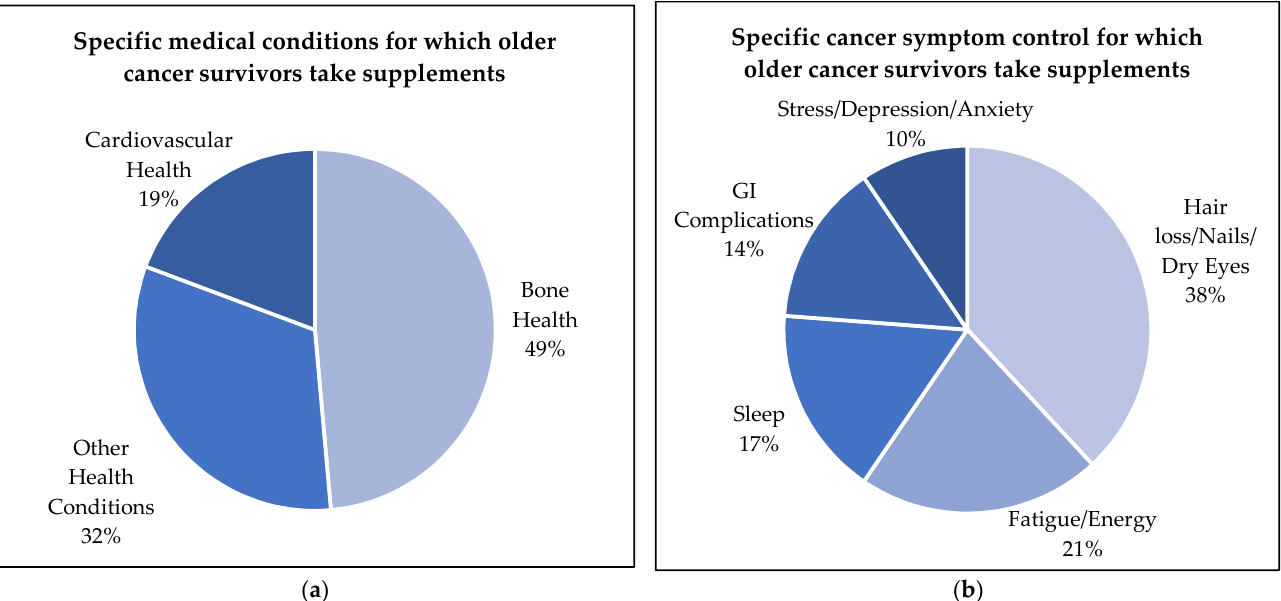
Figure 3. Sub-reasons of dietary supplement intake reported for ( a ) primary medical condition and ( b ) symptom control category among older cancer survivors ( n = 215). Table 3. Cost analysis of dietary supplements included in primary supplement categories 1